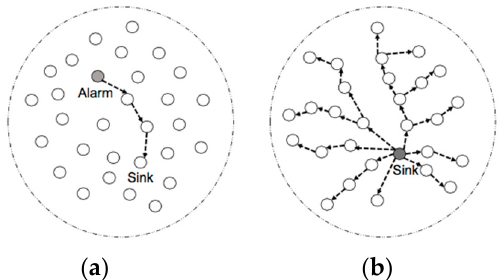
Figure 8. A multicast packet of the whole network simulation. ( a ) Unicast alarm packet sent to sink; ( b ) Sink forward alarm packet by multicast.